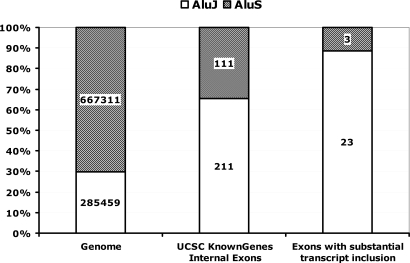
Most Alu exons with substantial transcript inclusion levels are derived from ancient Alu elements in the human genome.Plotted here are distributions of AluJ Class and AluS Class in the human genome, in Alu-derived internal exons, and in Alu-derived exons with substantial transcript inclusion levels based on our RT-PCR results. AluJ class is indicated by white column; AluS class is indicated by hatched column.